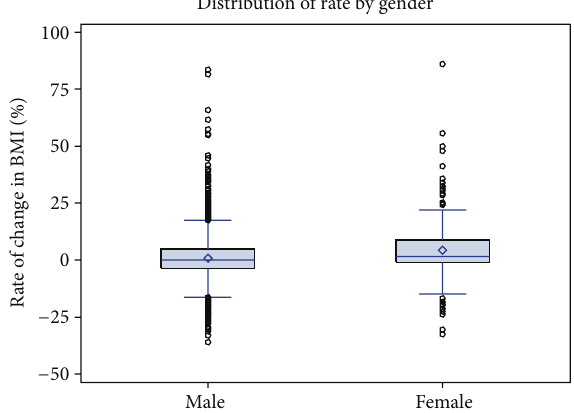
more weight than their male